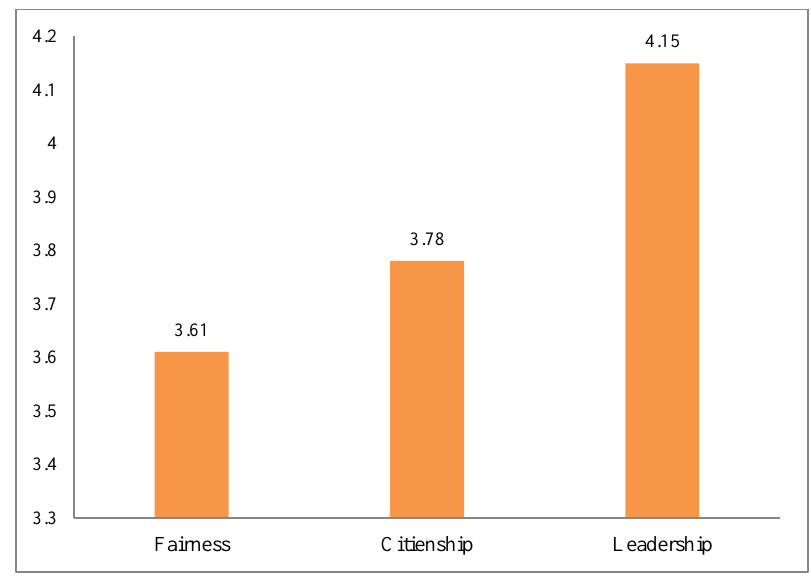
Fig. 5. 4th virtue: Justice (means, rated on a 5-point scale,